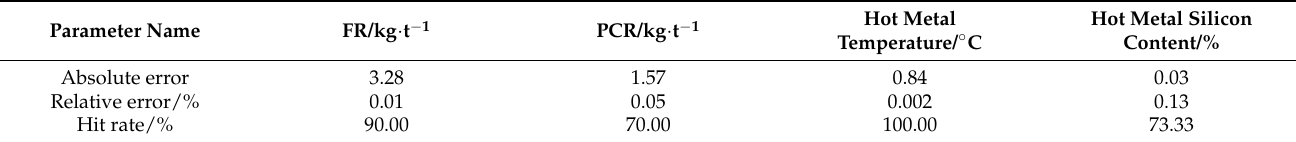
Table 2. Evaluation indicators for model.